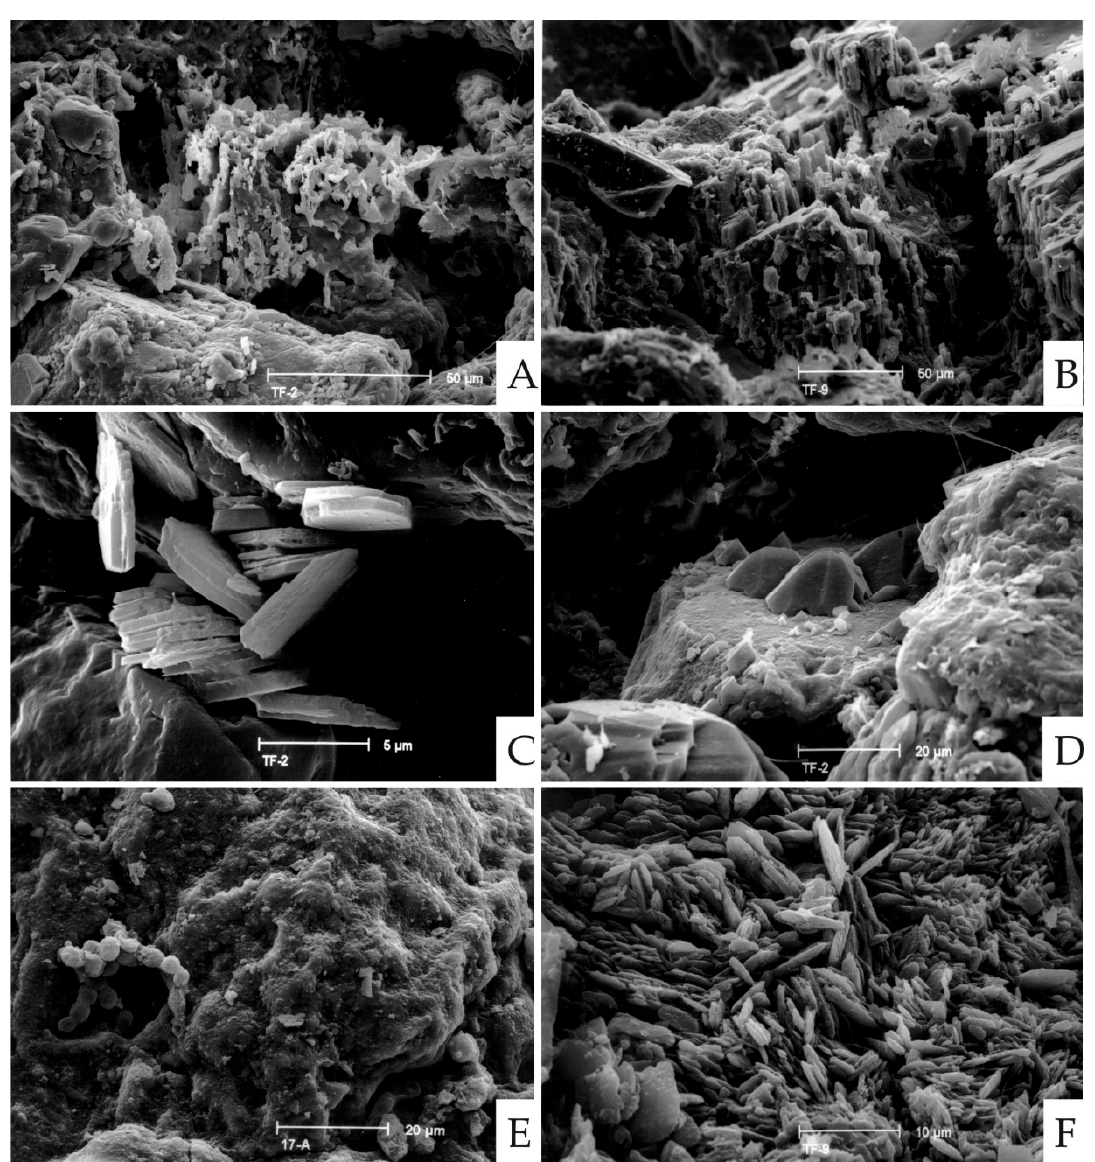
Figure 5. SEM micrographs. ( A ) Altered Na-feldspar crystal; on right, authigenic kaolinite cement. ( B ) Altered K-feldspar; note the development of intracrystalline fractures and etching features on crystal surfaces. ( C ) Detail of authigenic kaolinite aggregates showing booklet morphology. ( D ) Siliceous overgrowth on quartz crystal. ( E ) Organic biofilm coating quartz grain surfaces. ( F ) Brucite aggregates.